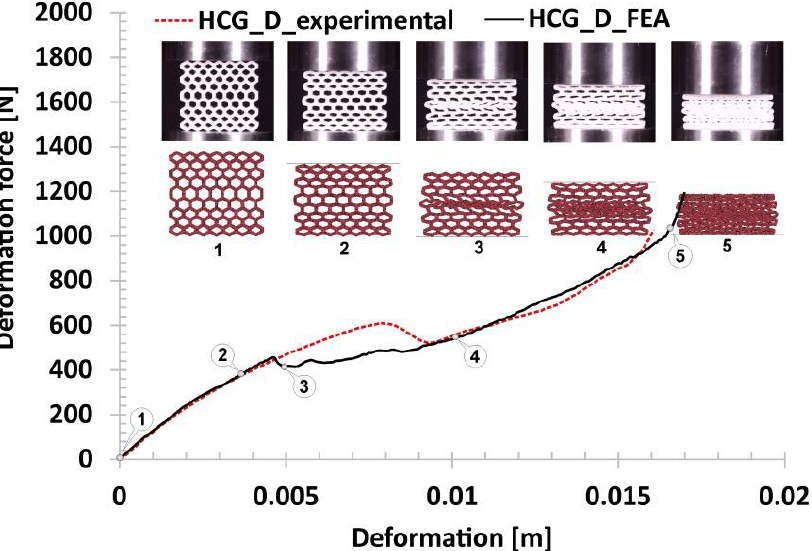
Figure 23. The results of the gradually decreasing honeycomb compression tests obtained based on the FE analysis. Polymers 2020 , 12 , x FOR PEER REVIEW